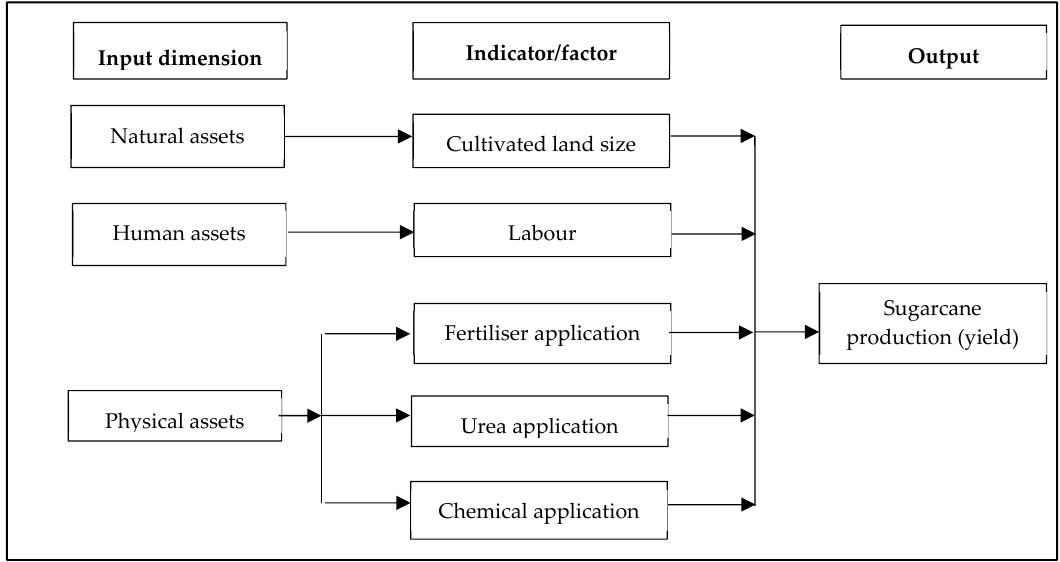
Figure 2. Conceptual framework of the factors affecting sugarcane production in Mona and Sonkombo.